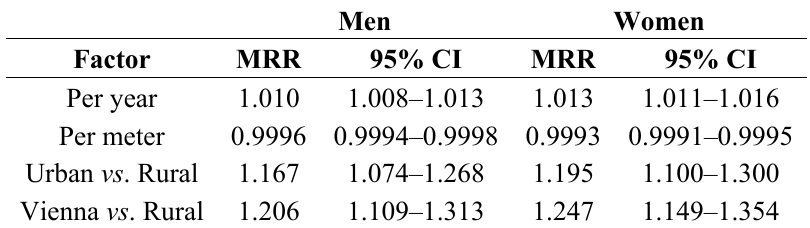
Table 1. Age-standardized melanoma mortality rate ratios (MRR) and 95% confidence intervals (CI) for selected risk factors according to logistic regression (for the years